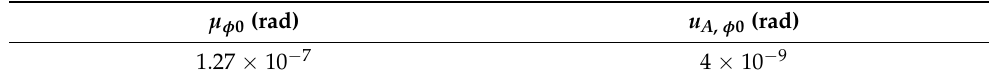
Table 9. “Actual zero phase displacement” characterization results.